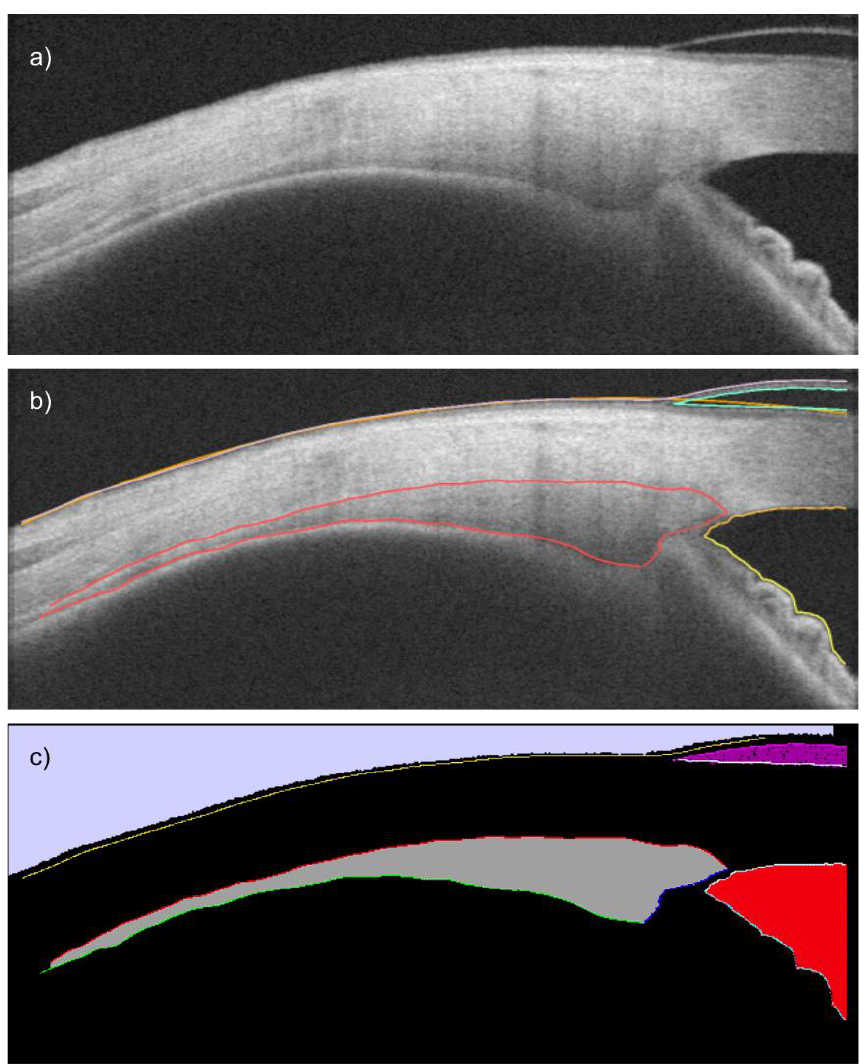
Figure 1. ( a ) OCT image of the ciliary muscle (here with eye wearing a soft contact lens) (feature image), ( b ) the semi-automated segmentation (red: ciliary muscle borders, orange: scleral-conjunctival boundary, turquoise: contact lens, yellow and orange: anterior chamber borders), ( c ) the label image based on image ( b ) with the 13 segmentation classes (Table 1) used as Ground truth for training the network.